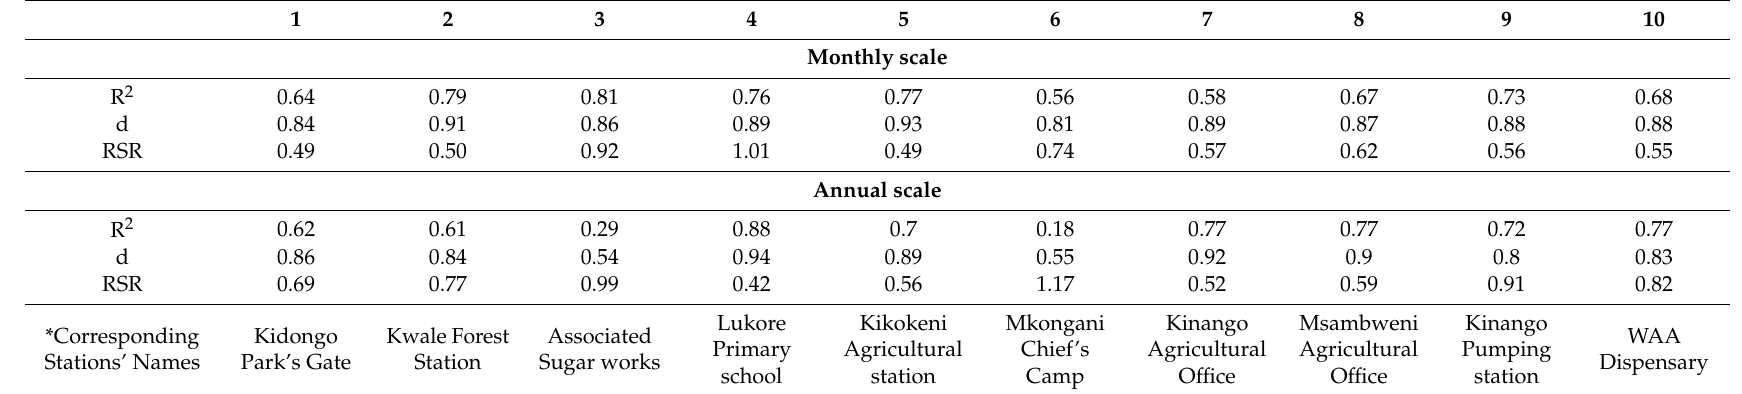
Table 3. Computed statistics of goodness-of-fit between observed and Climate Hazards Group InfraRed Precipitation with Station (CHIRPS) rainfall data for ten stations and for the period